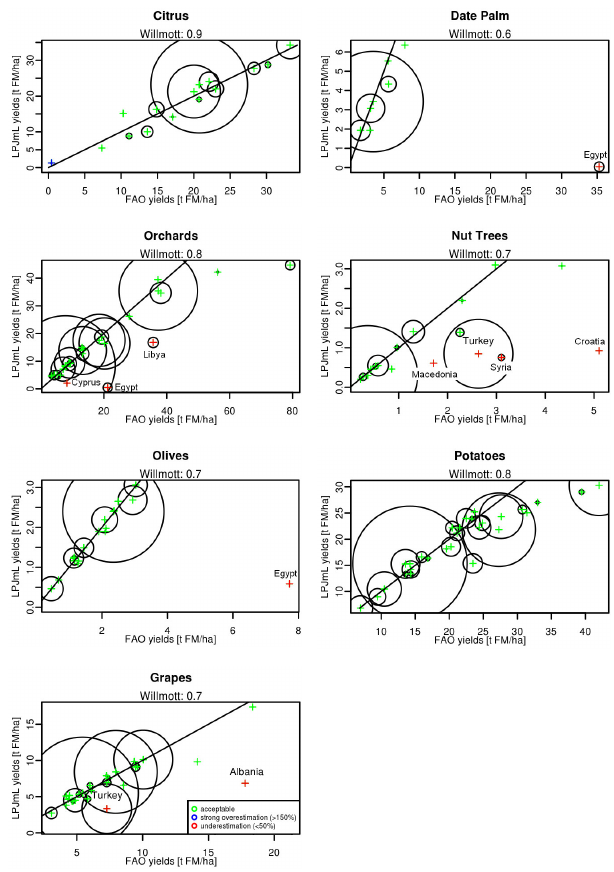
Figure 1. Scatter plot of LPJmL-simulated yields (averages over 2000–2009) versus reported yields from FAOSTAT for Mediter- ranean countries. The line represents the 1 : 1 line. FM stands for fresh matter. The radius of the bubbles indicates the relative size of the harvested area in the respective